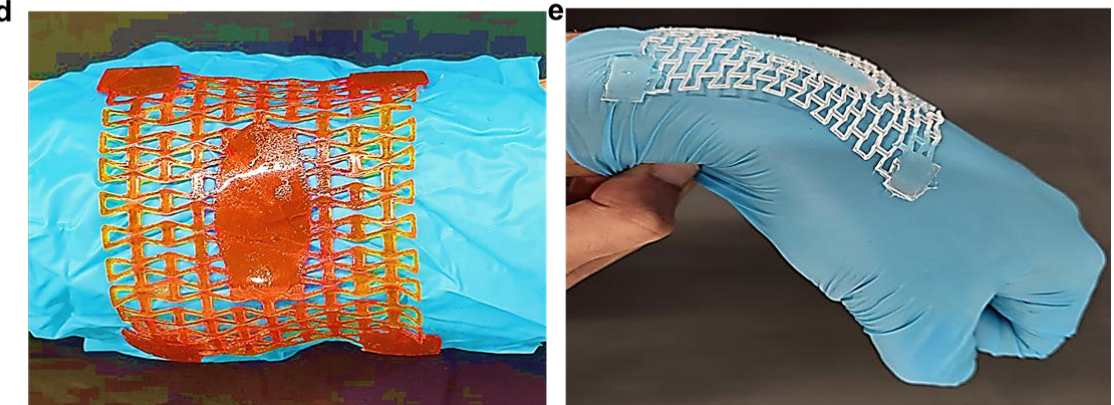
Figure 7. The adhesion strength with different PAA concentrations. ( a ) The PAA and water mixture. ( b ) Shear stress vs. strain for different mixtures of PAA and water. ( c ) Hydrogel sample attached to glass strip using PAA for 24 h. ( d ) The morphological motion of the unit re-entrant phenol red incorporated wound dressings cells when curved in shape. ( e ) The morphological motion of the unit re-entrant cells when the hand joint bends.